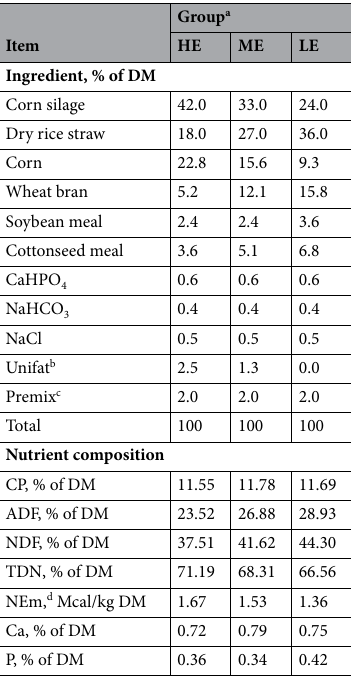
Less than 24 h postpartum, the birth weight and body height, body length, thoracic girth and umbilical girth of each calf were recorded. The number of newborn male calves in the HE, ME and LE groups are 13, 20 and 15 respectively. All measurements were taken when each calf was standing naturally with its head raised and weight was distributed on all four feet. Blood samples (5 mL) were collected from all calves via jugular venipuncture into sodium heparin-containing tubes within 4 h of birth; the calf blood samples were handled in a similar fashion as the cow blood samples, and the plasma was stored at − 20 °C for analysis of IL-2, IL-4, IL-6, total antioxidant capacity (T-AOC), maleic dialdehyde (MDA), glutathione peroxidase (GSH-Px), and superoxide dismutase (SOD) levels. Additional blood samples (5 mL) were collected after 24 h of birth, from the jugular veins of all calves into tubes containing no additives for serum harvest to evaluate serum concentrations of IgG. Plasma and serum samples were stored at − 20 °C until laboratory analysis.